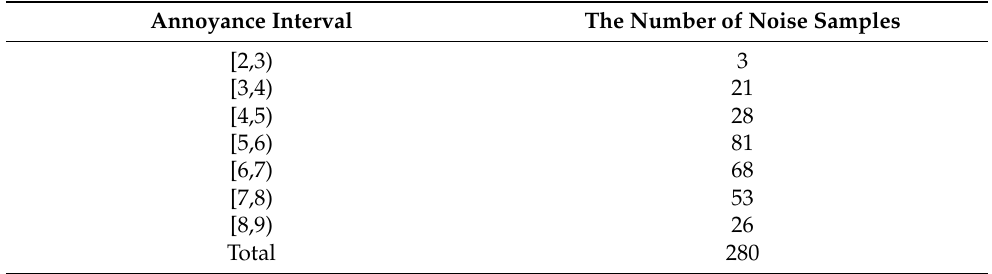
Table 4. The distribution of mixed set. It is used to evaluate the performance of all algorithms for the assessment of road noise annoyance The data format is the same as Table